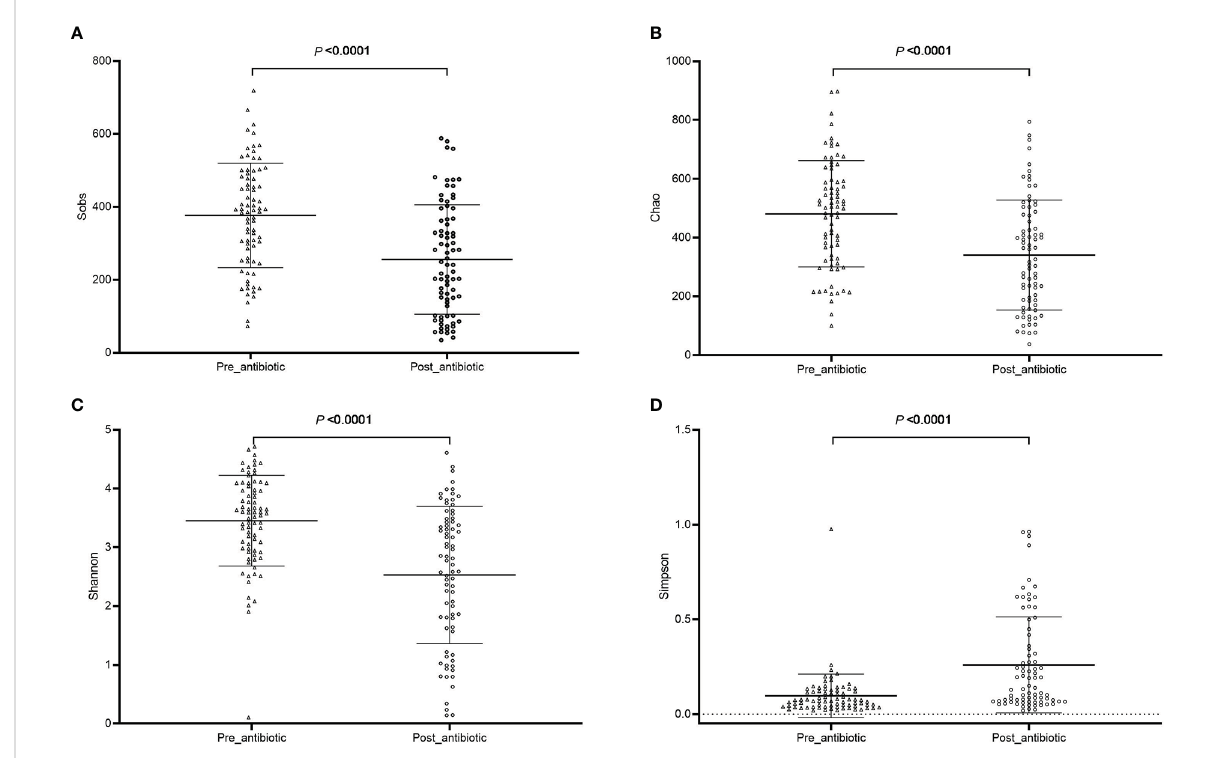
FIGURE 8 The community richness and diversity of gut microbiota for elderly patients. (A) : Sobs index; (B) : Chao index; (C) : Shannon index; (D) : Simpson